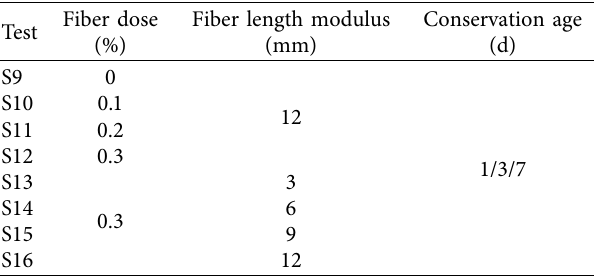
Table 4: Dynamic triaxial test scheme for solidification of remolded soil.